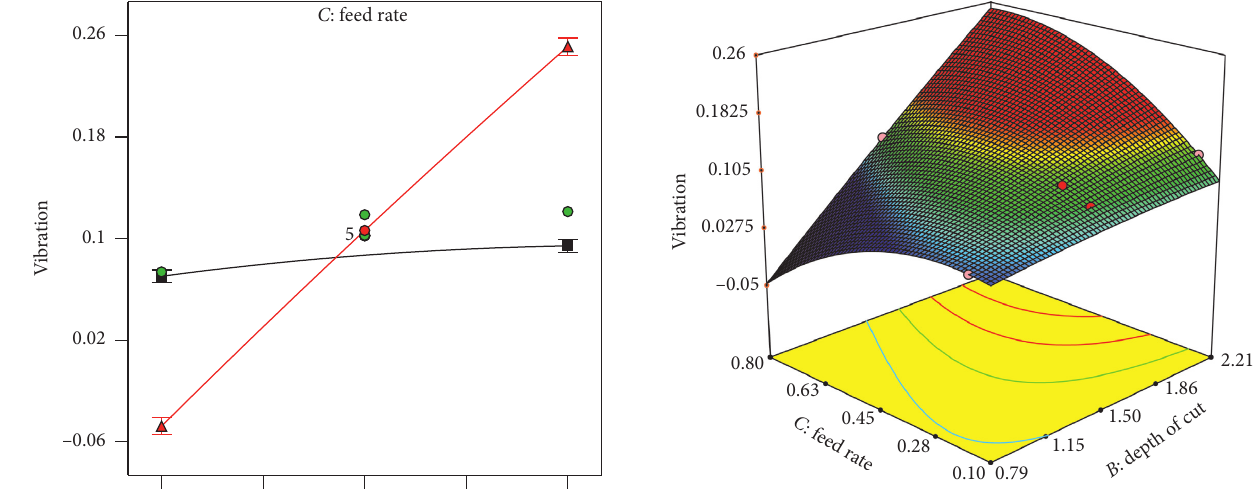
Figure 11: Surface plot for the